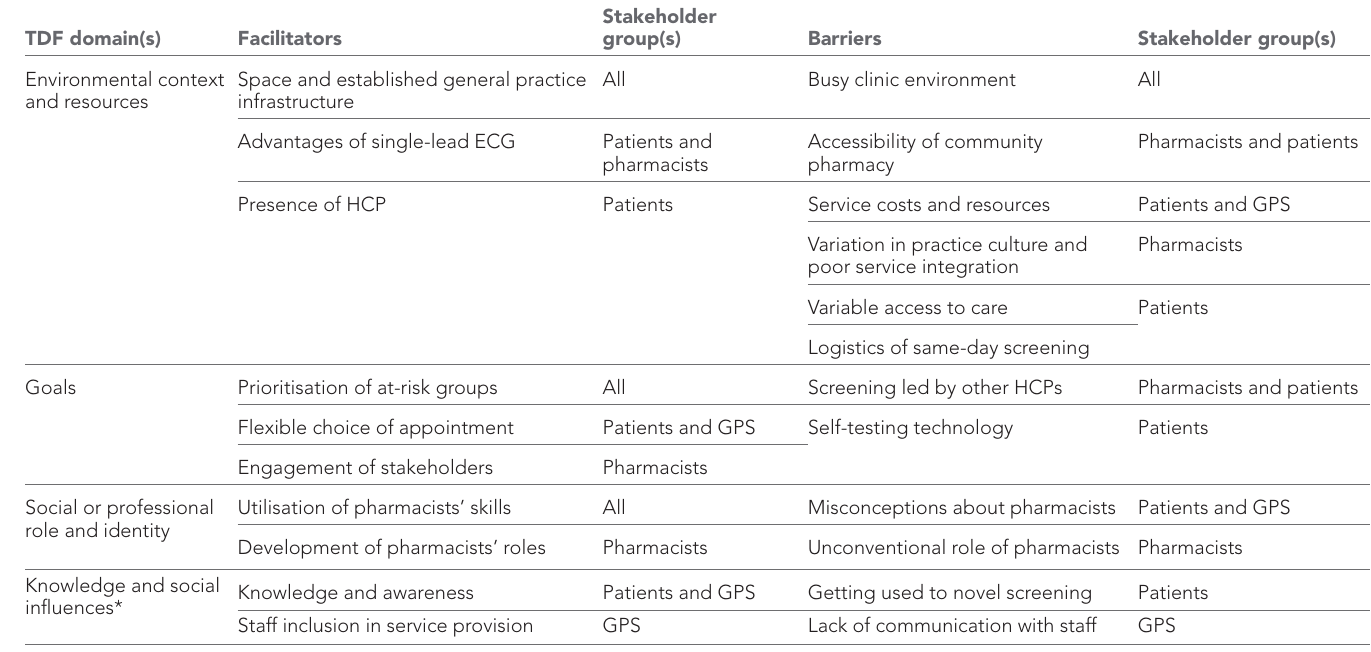
Table 2 Key facilitators and barriers to atrial fibrillation screening service proposed mapped against the most relevant TDF domains ( n = 25 for patients, n = 9 for GPS and n = 4 for